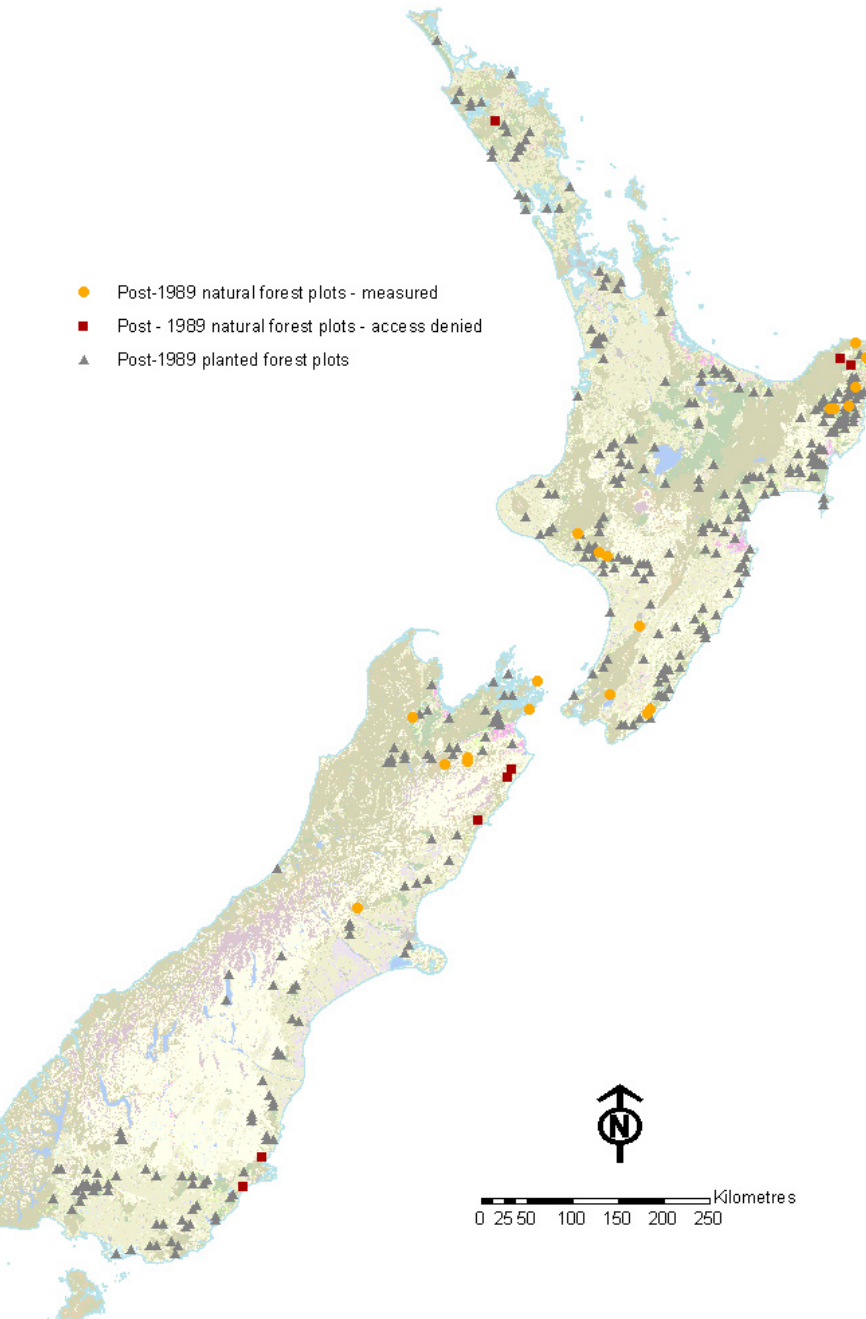
Figure 1. Location of sample sites in post-1989 forest in New Zealand. The majority occurs in planted forest. Natural forest plots were established at 20 of the 28 potential locations where natural forest intersected the 4-km grid used to sample post-1989